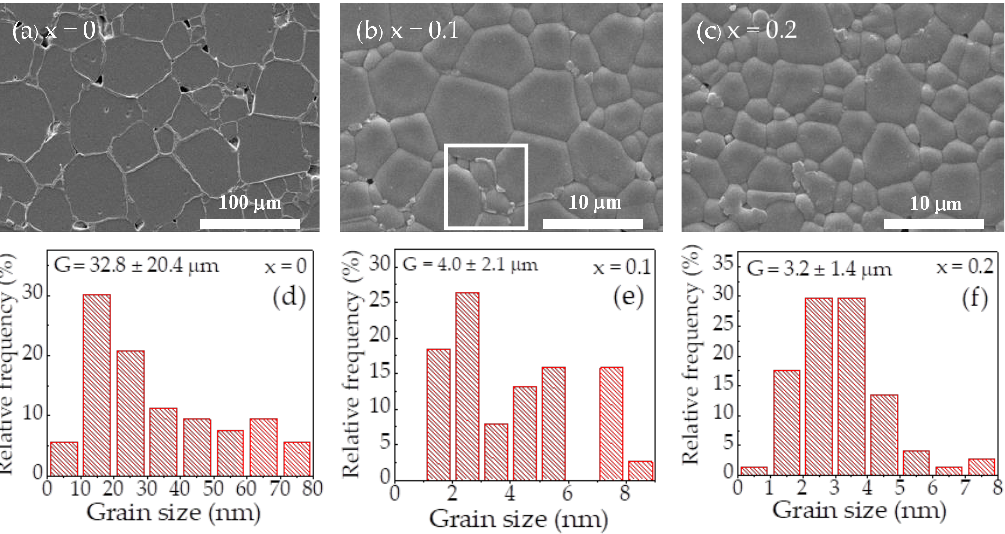
Figure 5. SEM images of NYCTO + xTiO 2 ceramics with x = ( a ) 0.0, ( b ) 0.1 and ( c ) 0.2 and grain size distributions of NYCTO + xTiO 2 ceramics with x = ( d ) 0.0, ( e ) 0.1 and ( f ) 0.2.